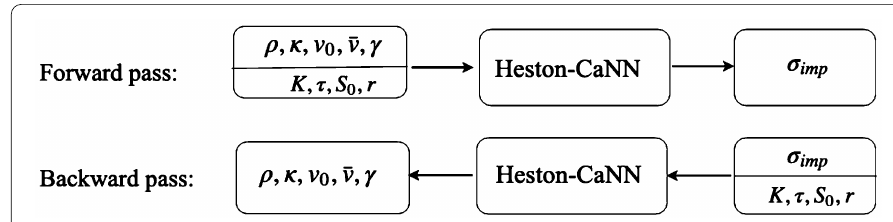
Figure 7 The Calibration Neural Network for the Heston model